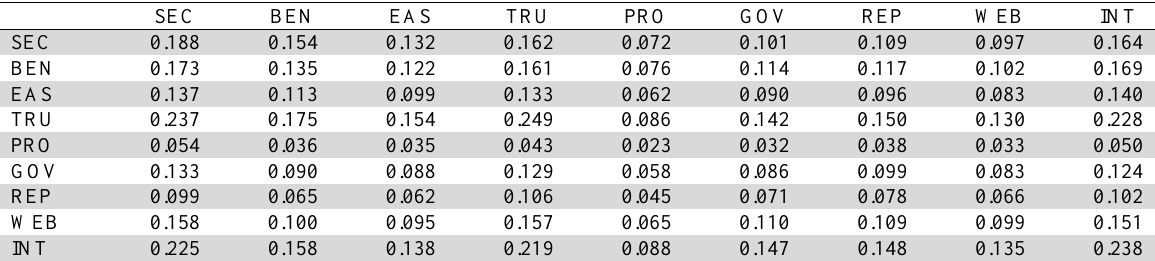
The results of indirect effects